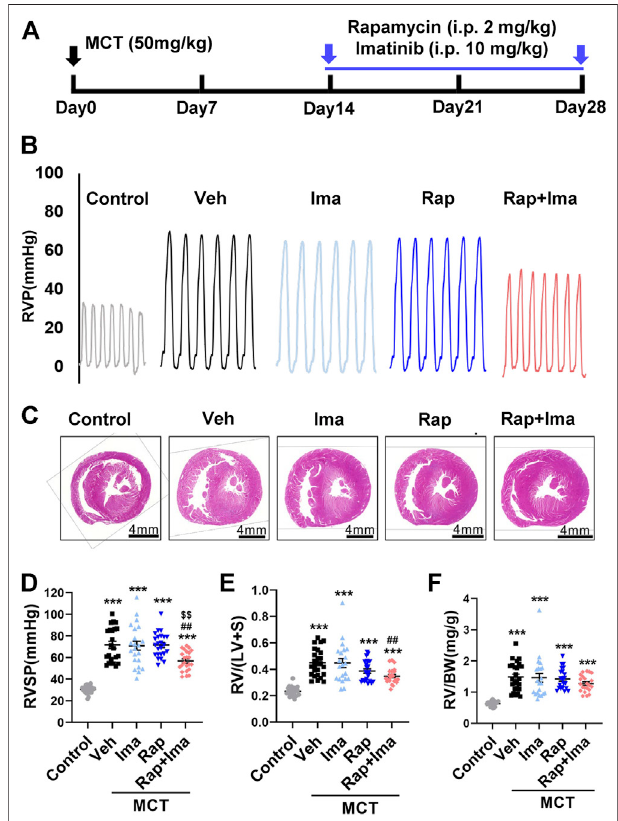
FIGURE 4 | Rapamycin combined with imatinib attenuates PH induced by MCT. (A) Schematic strategy for the MCT-induced PH rodent model and drugs administration. (B) Representative record of right ventricle pressure (RVP) in control and MCT rats treated with vehicle (Veh), imatinib (Ima), rapamycin (Rap), or combination of rapamycin and imatinib (Rap + Ima). (C) H&E stainingofheart tissue ineach group. (D,E,F) Summarized datashowing RVSP,Fultonindex([RV/(LV+S)])andtheratioofrightventricleweighttobody weight (RV/BW) respectively. Data are presented as the mean ± SE. One-way ANOVA was used for statistical analysis. *** p < 0.001, ** p < 0.01, * p < 0.05 versus control; ### p < 0.001, ## p < 0.01, # p < 0.05 versus MCT with